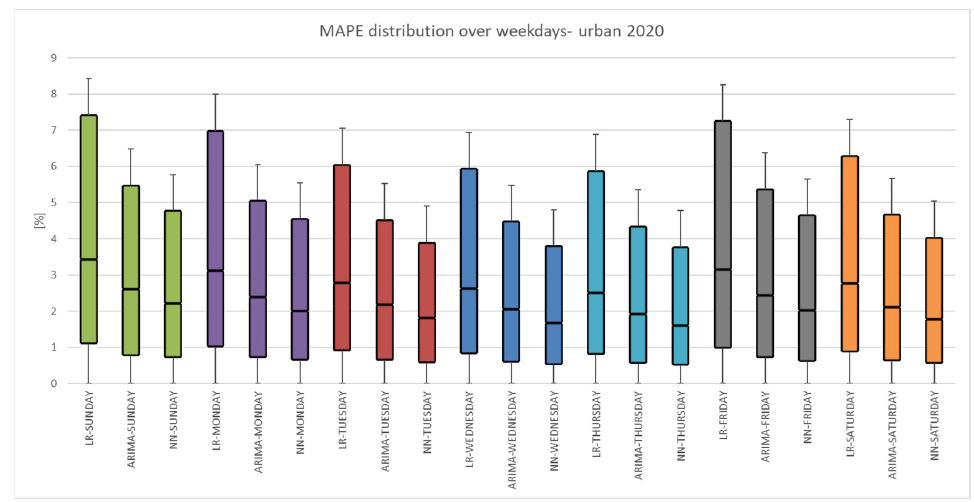
Figure 11. Overall forecasting results for urban consumers in 2020.